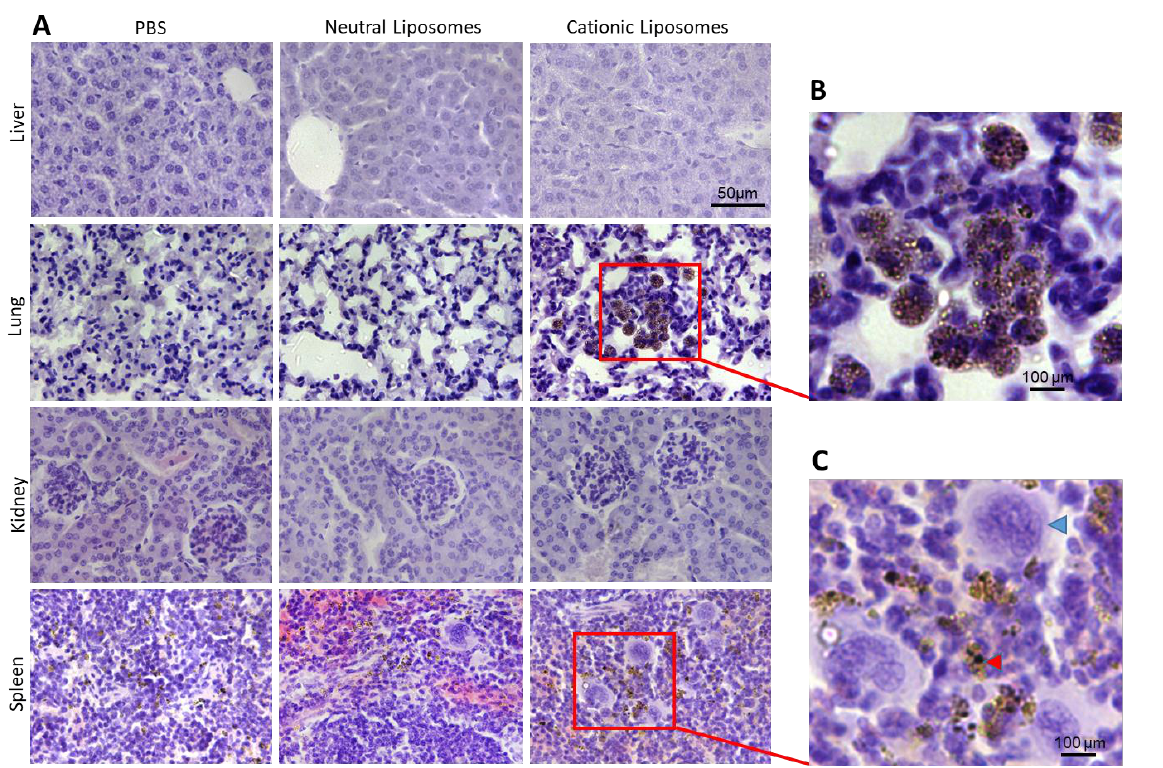
Figure 7. ( A ) Histopathological analysis of liver, lung, kidney, and spleen from mice treated with PBS, neutral, or cationic liposomes (bar depicts 50 µm) (10× magnification). ( B ) Magnification of a lung area from mice treated with cationic liposomes displaying brown pigment (hemosiderin) contained within alveolar macrophages. ( C ) Magnification of a spleen area from mice treated with cationic liposomes depicting brown pigmentation (hemosiderin, red arrowhead) and megakaryocytes (blue arrowhead). Bar in ( B , C ) represents 100 µm (40× magnification).